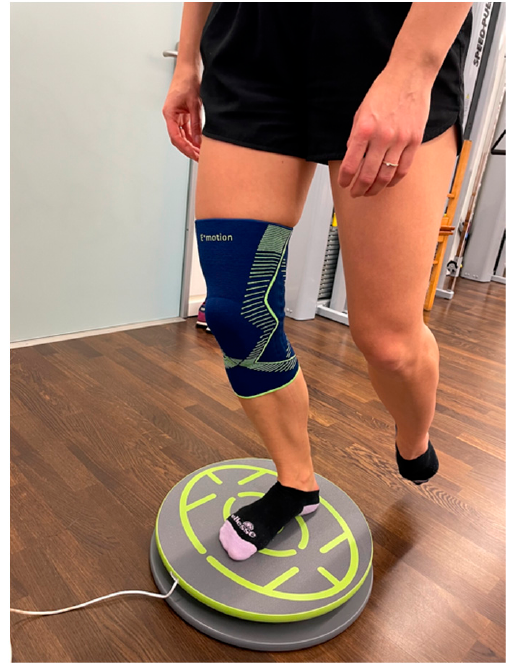
Figure 1. Single Leg Balance Test.